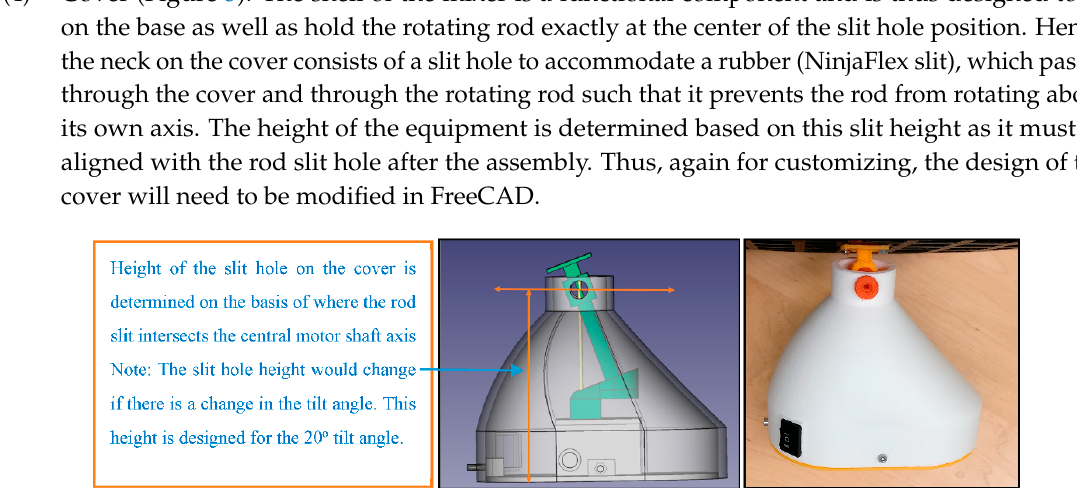
Figure 4. Rod design for the open source nutating mixer.